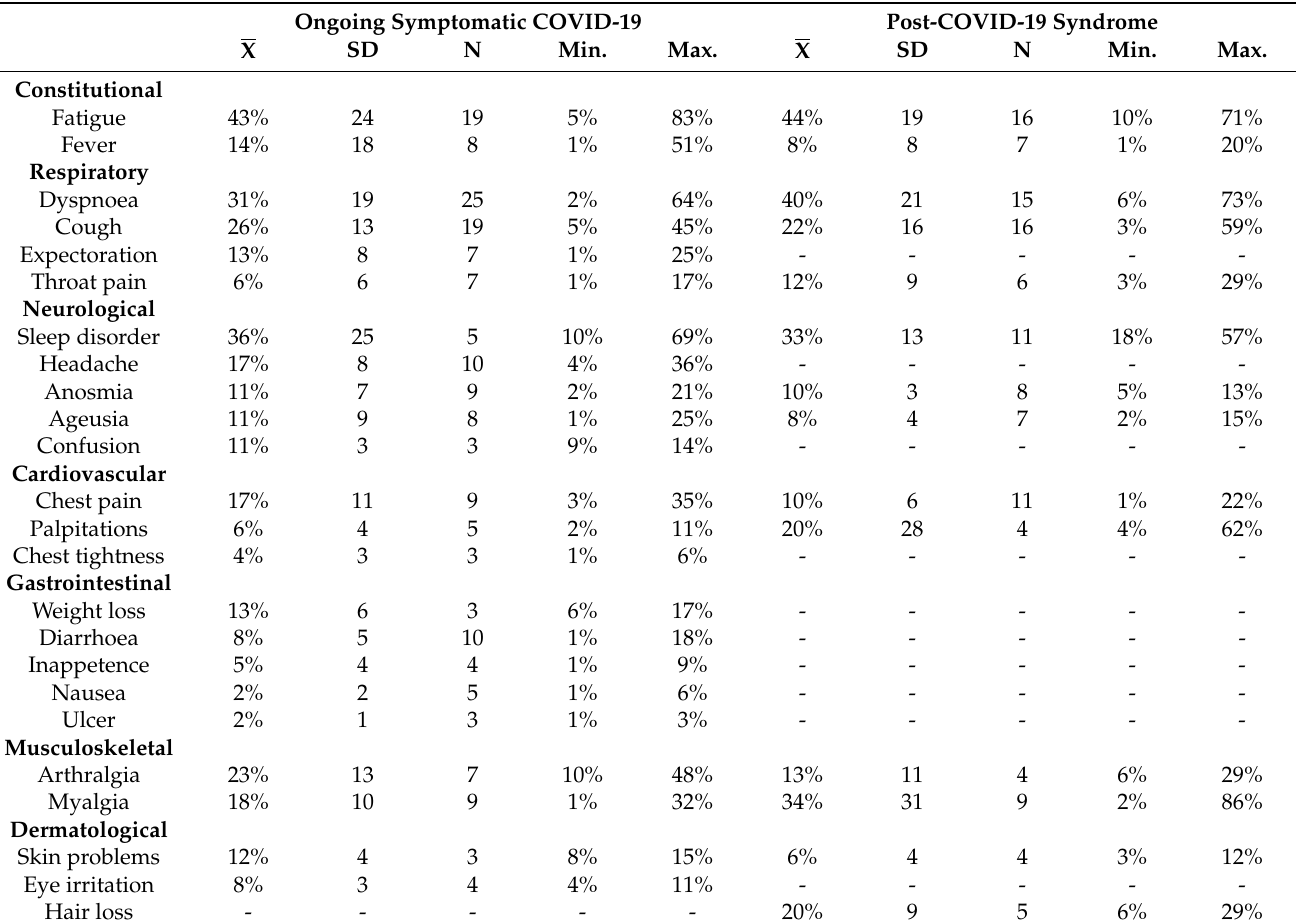
Table 4. Symptom Prevalence of Long COVID